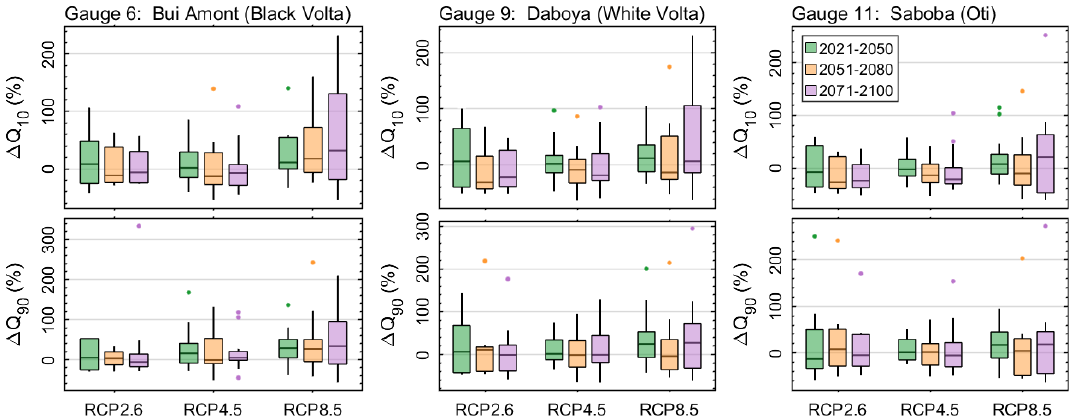
Figure 12. Changes in future high flows ( Q 10 ) and low flows ( Q 90 ) in the major sub-basins of the VRB (Black Volta, White Volta, and Oti). The changes in percentage over the future periods are relative to the historical period (1991–2021).